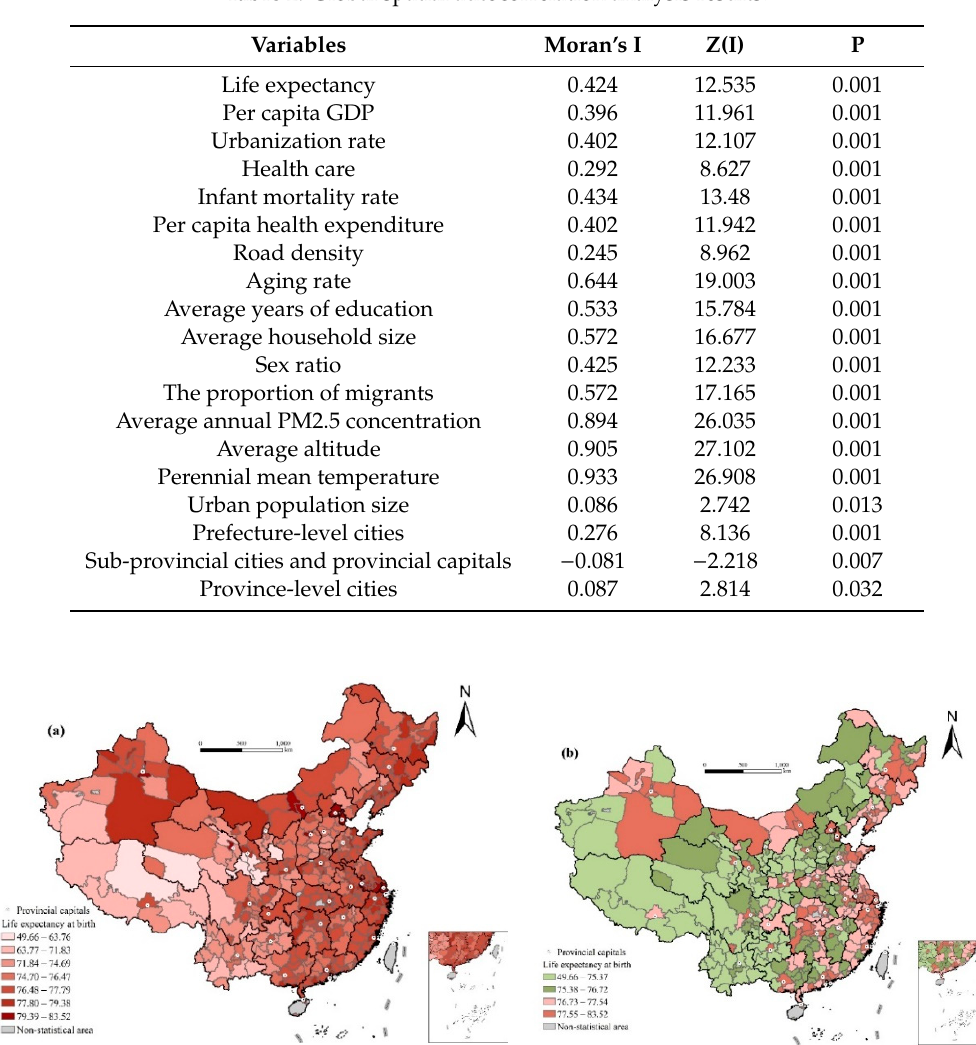
Table 2. Global spatial autocorrelation analysis results.